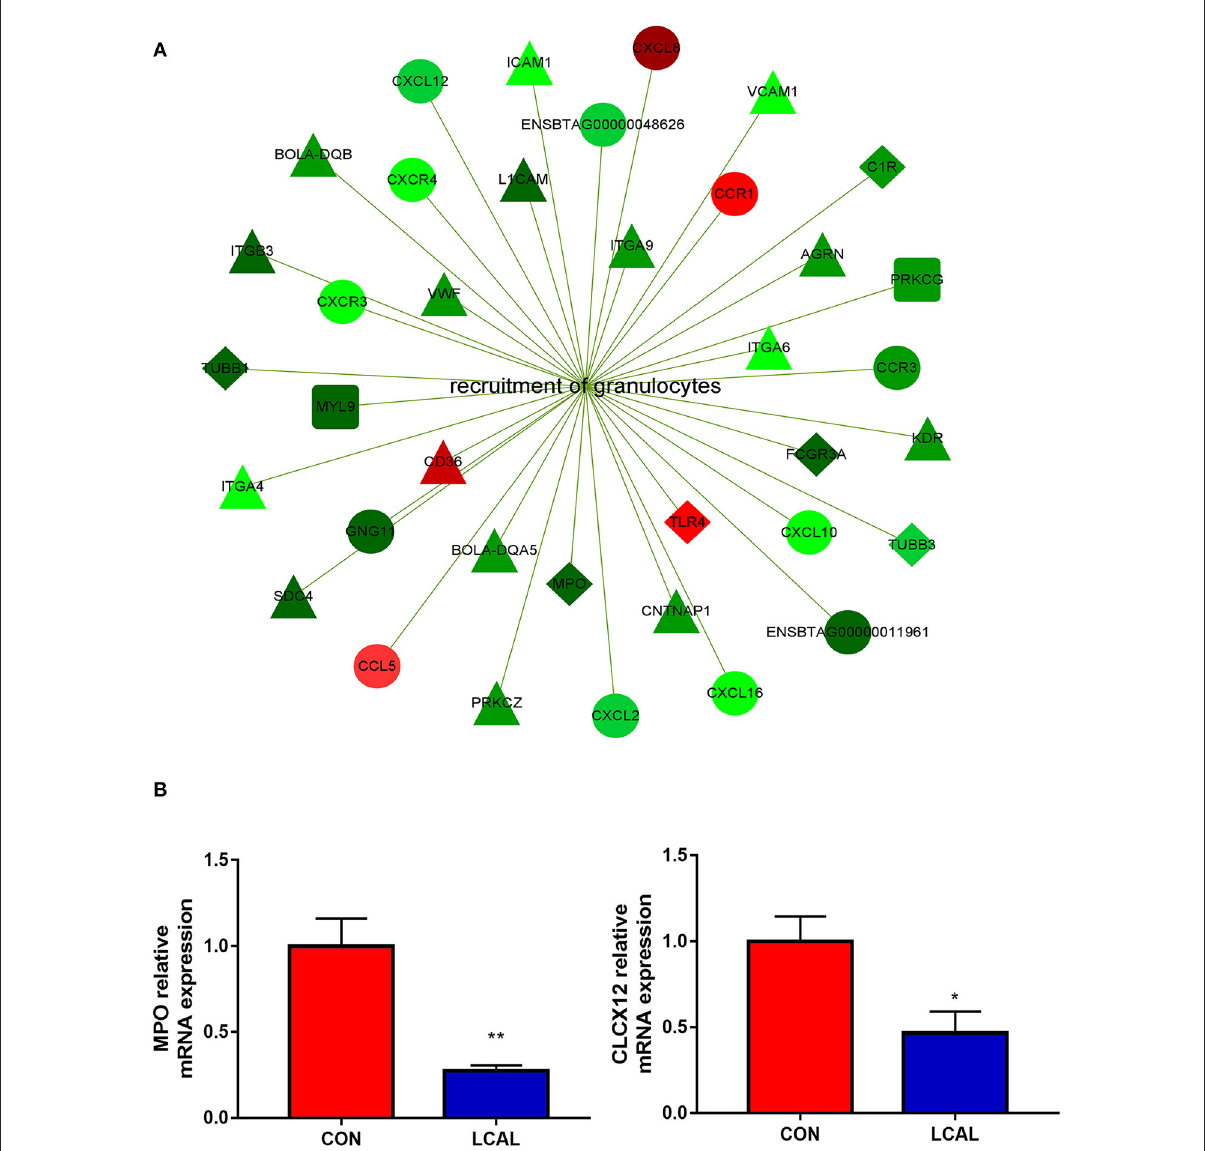
FIGURE2 (A) Genes related to granulocyte recruitment that were differentially expressed in the PMNL of LCAL group. The color intensity indicates the degree to which the relative expression increased (red) or decreased (green) [mean ± SEM ( n = 5)]. This pathway was generated through the use of Cytoscape (https://apps.cytoscape.org/). (B) Randomly selected genes for verification that are related to granulocyte recruitment [means ± SEM ( n = 3)].* P < 0.05, ** P < 0.01, means there is a significant difference from the comparison table. (one-way analysis of variance).